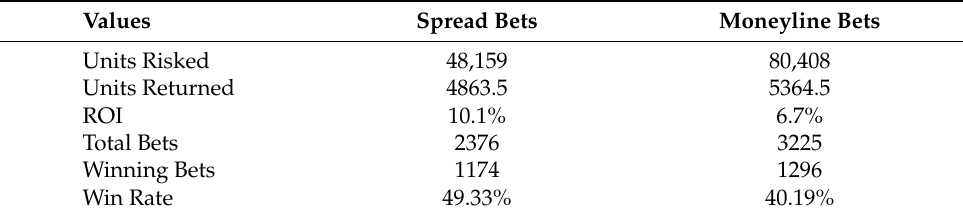
Table 9. Meta-Swarm: Risk, Return and Win Rate (Accuracy) for Spread and Moneyline Bets. Values Spread Bets Moneyline Bets Units Risked 48,159 80,408 Units